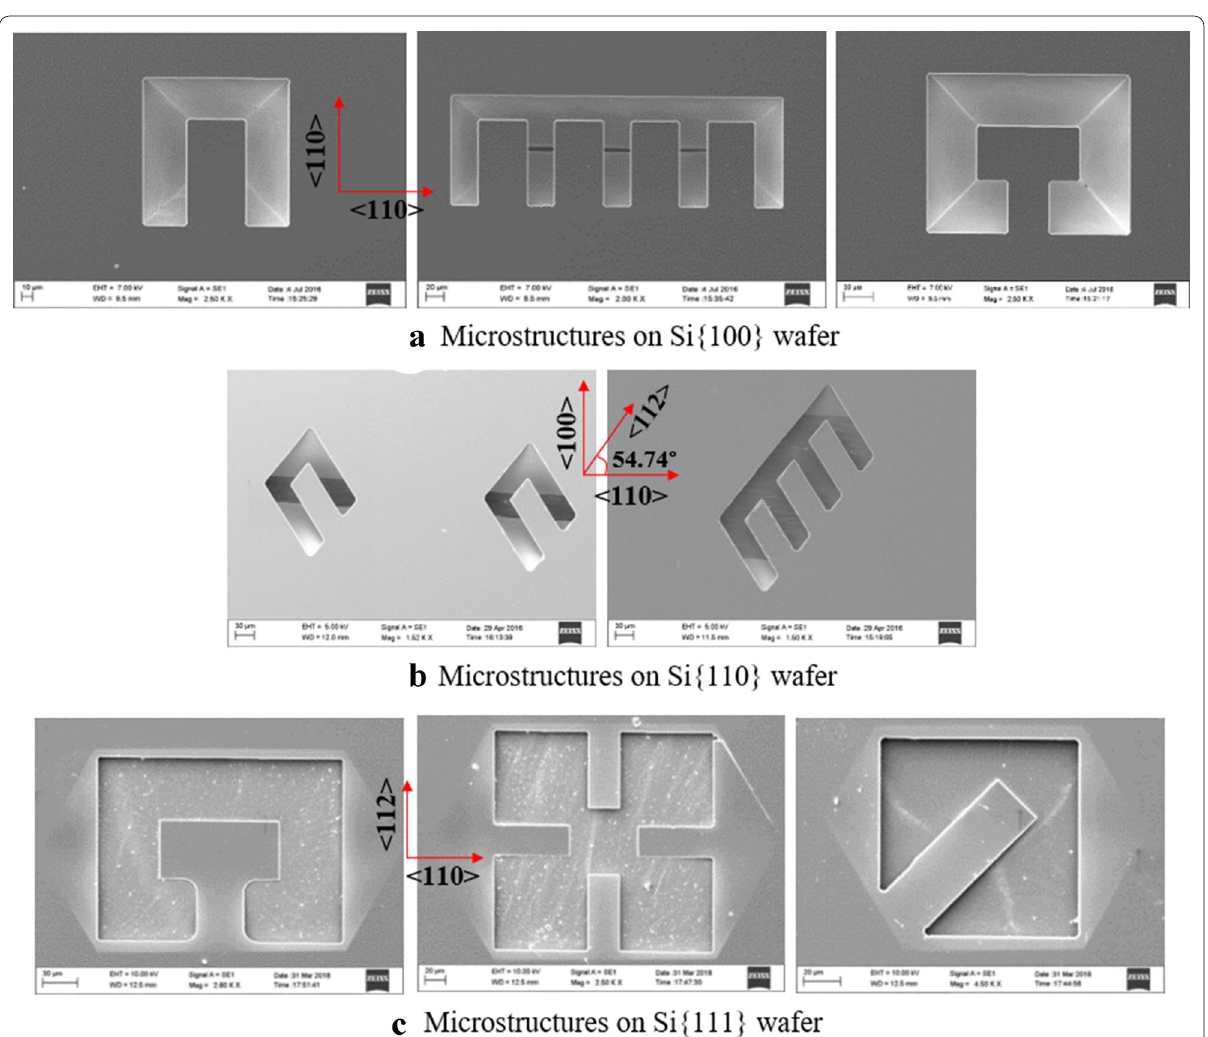
Fig. 65 SEM images of suspended SiO 2 microstructures fabricated on a Si{100}, b Si{110}, and c Si{111} wafers in NH 2 OH-added TMAH